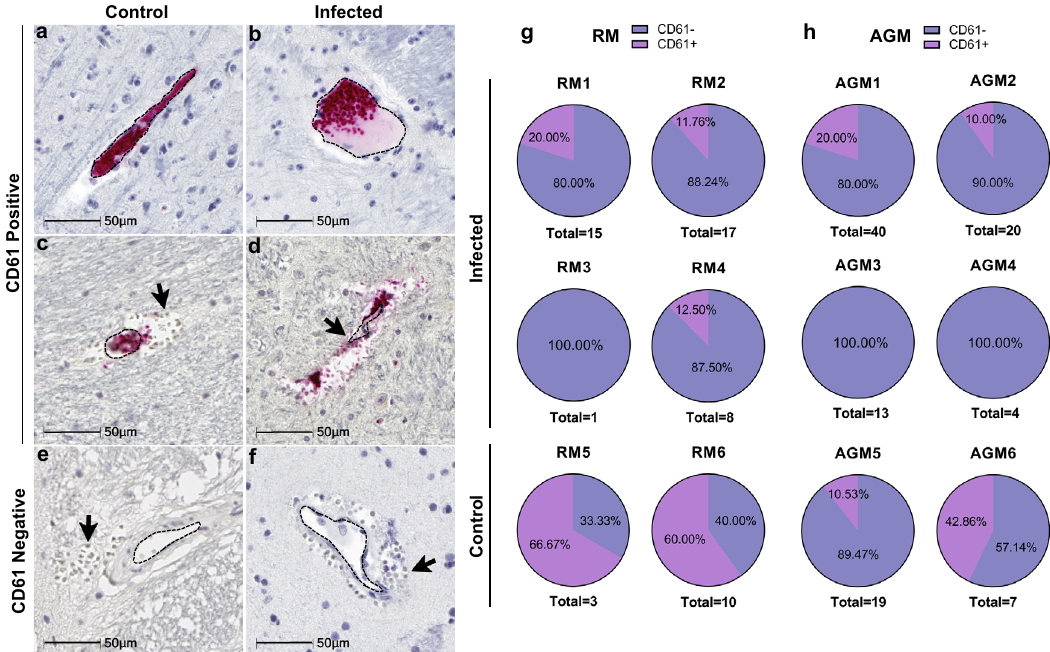
Fig. 4 Reduced CD61 positive associated-microhemorrhages in SARS-CoV-2 infected NHPs. Representative images show CD61 positivity in intact vessels in parietal lobe from control animal AGM5 ( a ) and temporal lobe ( b ) from infected AGM4. CD61 positivity was also seen in association with microhemorrhages, as shown in control cerebellum of AGM5 ( c ) and brainstem of infected RM2 ( d ). Microhemorrhages without CD61 positivity were also observed in both non-infected (RM5 brainstem e ) and infected (RM1 temporal lobe f ) but was more frequent in infection. The percent frequency of microhemorrhages with and without CD61-associated platelet aggregates is shown for each species ( g and h ). Immunohistochemical staining for CD61 was performed twice on all brain regions. Source data are provided as a Source Data fi le. Abbreviations: AGM African green monkey, RM Rhesus macaque. Scale bars = 50 µ